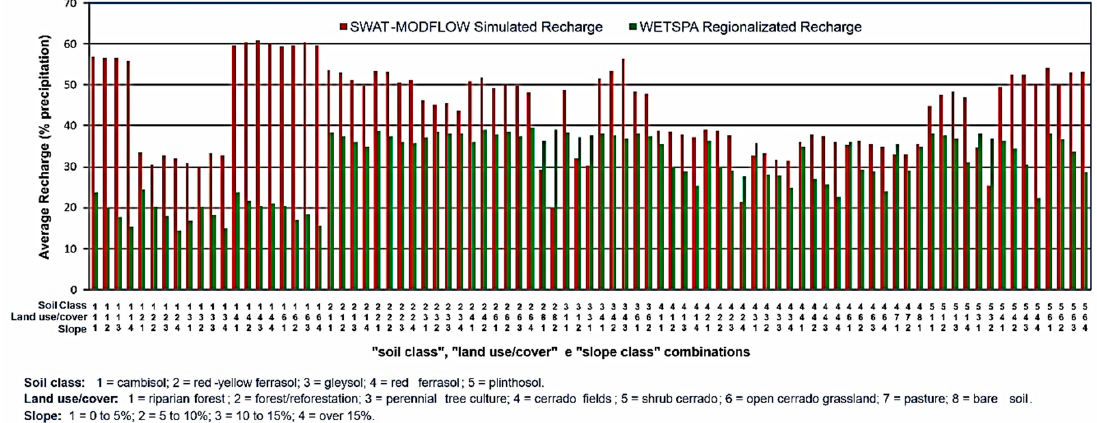
Figure 4. ( a ) Spatial distribution of the simulated recharge; ( b ) Spatial distribution of the regionalized recharge.